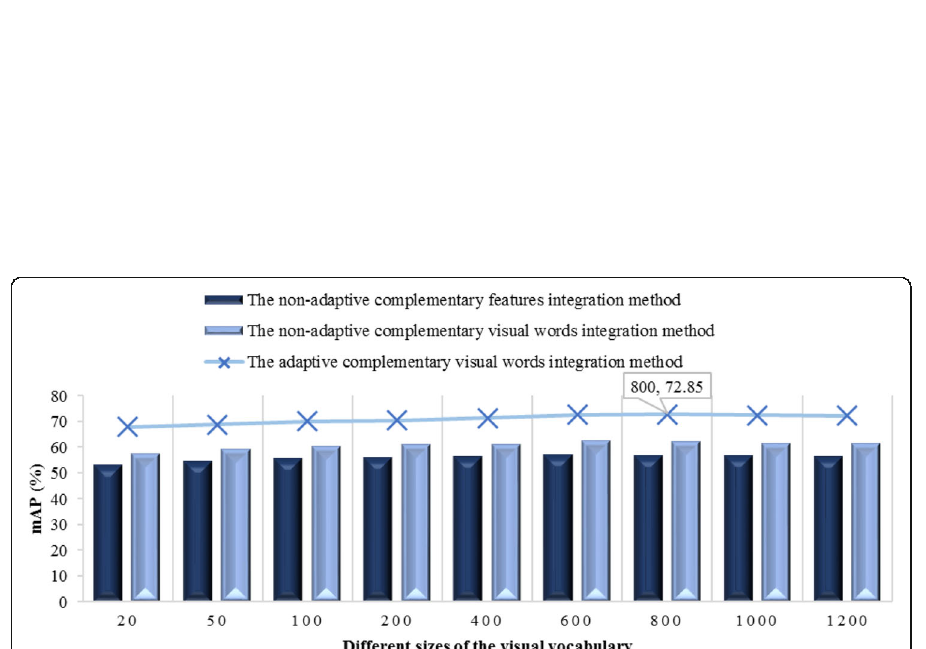
Fig. 16 Comparison of mAP of the proposed method with competitive CBIR methods on the Holidays image dataset